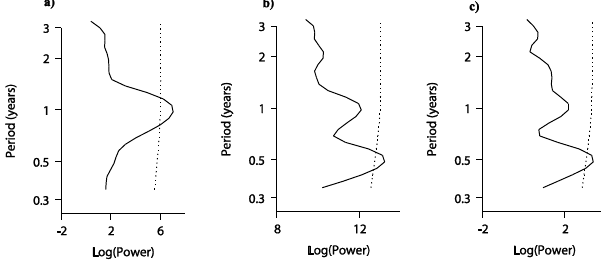
Fig. 4. The global power spectrum for (a) PC(1), (b) PC(2) and (c) PC(3). The dotted line is the 95% confidence Figure 4. The global power spectrum for (a) PC (1) , (b) PC (2) and (c) PC (3) . The dotted 413 line is the 95% confidence level. 414